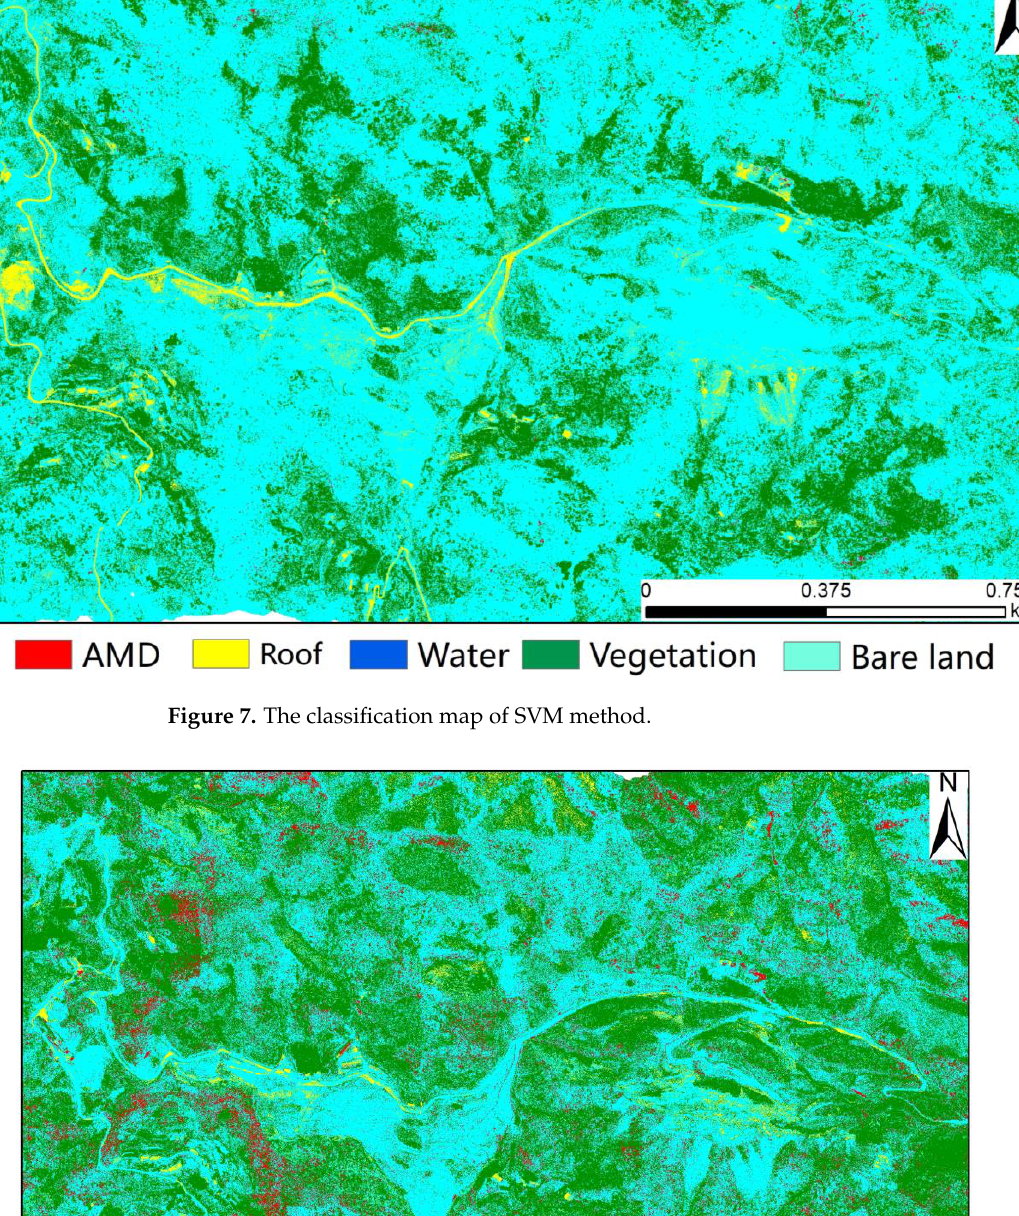
Figure 9. The classification map of U-Net method. A small scale of the classification area was selected for detail comparisons among the results of the different methods and the classes (Figure 10a). Among the vegetation classi- fication results of all the three methods, the SVM method mapped a smaller vegetation